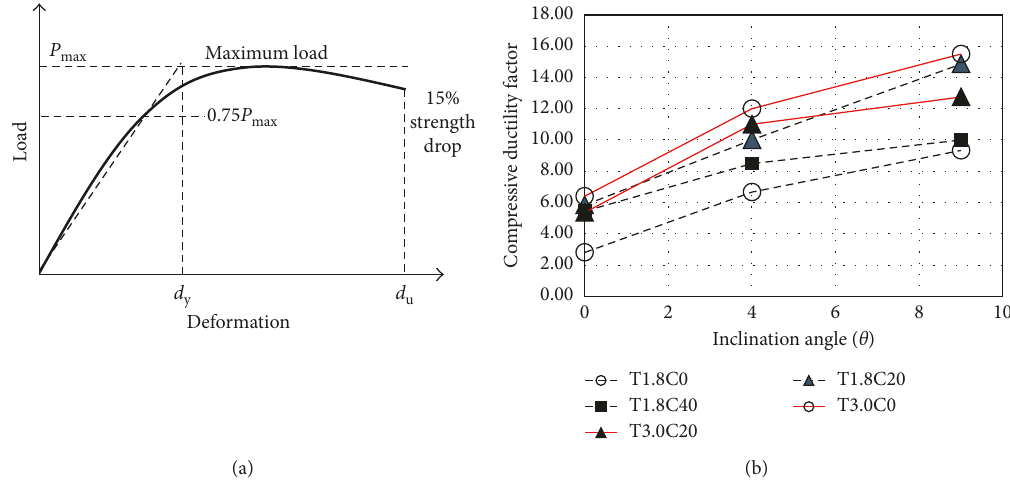
Figure 8: Ductility factor. (a) Determination of the ductility factor. (b) Compressive ductility factor of the samples.